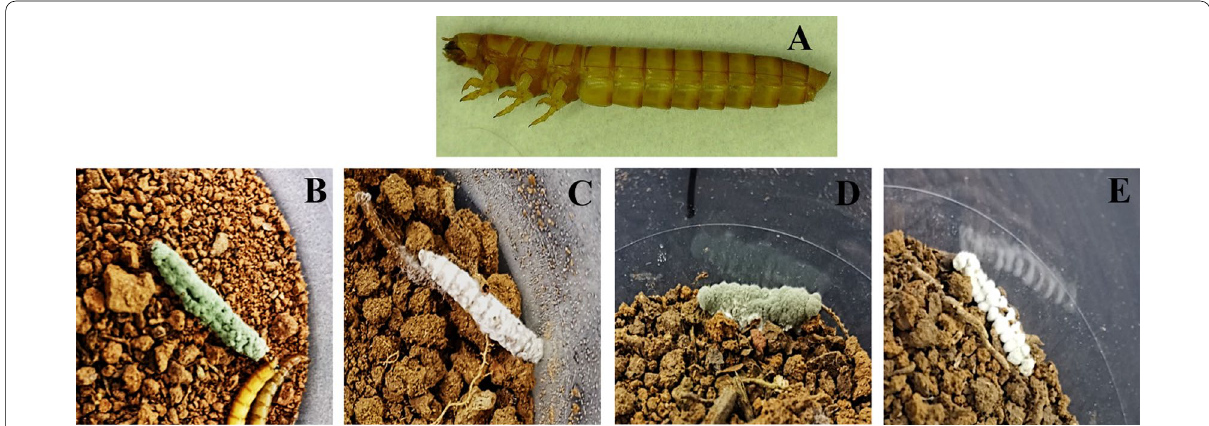
Fig. 1 Larvae of Tenebrio molitor with mycoses symptom. A Healthy larvae, B – E Larvae with mycoses symptom during baiting of EPF in the soil sample